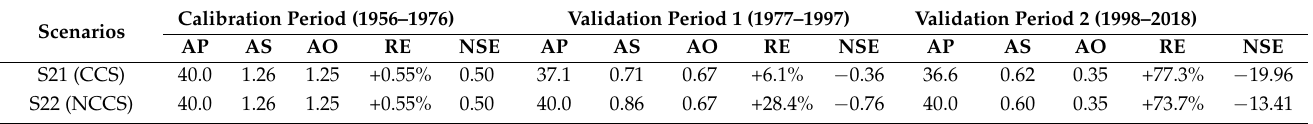
Table 6. Simulated results of S2.